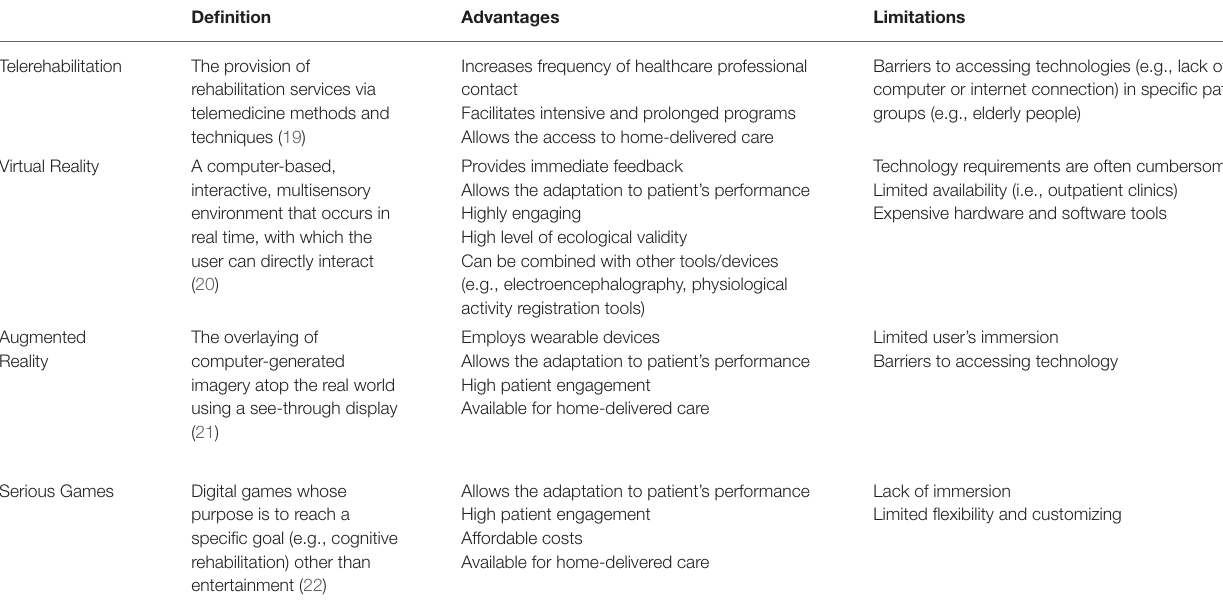
TABLE 1 | Main methods and technologies for cognitive